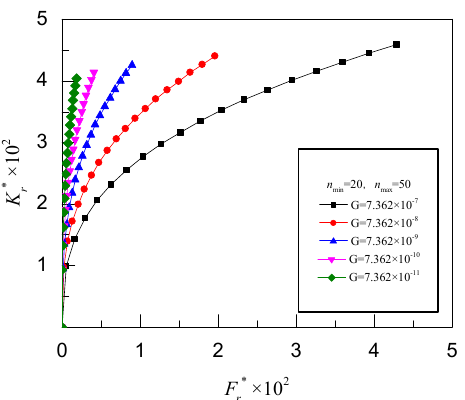
Figure 7. Relationship between dimensionless normal contact stiffness K ∗ r and characteristic length scale G .